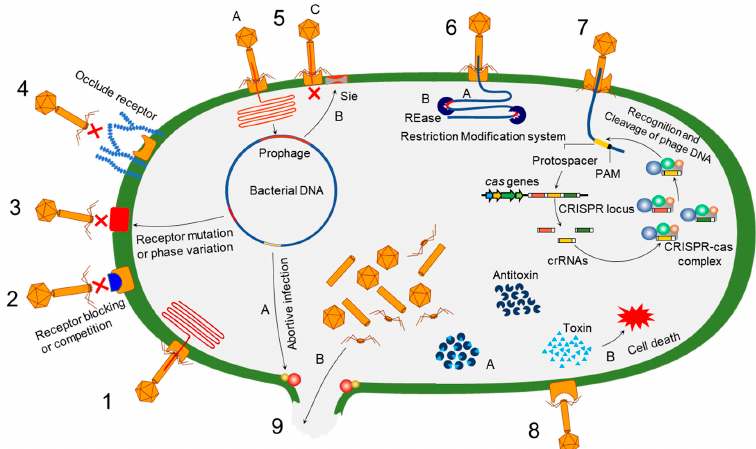
Figure 1. Overview of bacterial antiphage defense mechanisms. 1. Phage infection: successful phage attachment and infection; 2. competition in receptor binding: blocking of the phage-binding receptor to evade phage attachment; 3. alteration in cell surface receptor: mutation or phase variation in the receptor to avoid phage attachment; 4. hiding phage receptor: production of extracellular polysaccharides to hide phage receptor; 5. superinfection exclusion—A: integration of prophage into host genome; B: expression of protein to block DNA entry; C: exclusion of